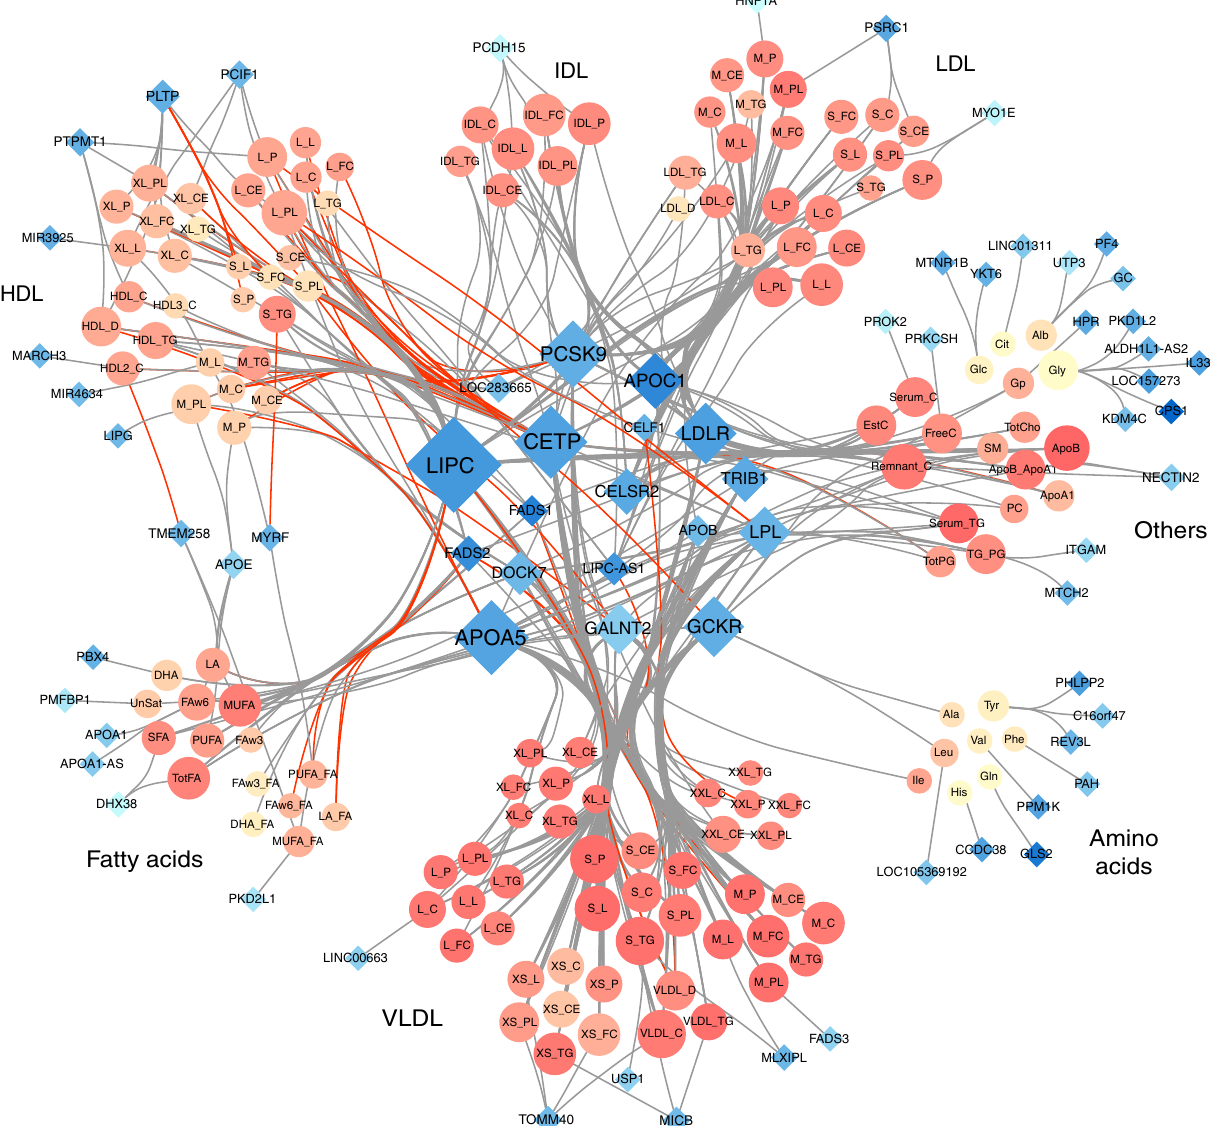
Fig. 3 Network representation of the 588 region-metabolite associations identi fi ed in the 158 metabolites GWAS in METSIM. For each region we used the nearest gene of the most associated variant. Each node represents either a gene (blue diamonds, N = 70) or a metabolite (orange circles, N = 147). Each edge is an association between one gene and one metabolite. Node size is directly proportional to the number of other nodes associated with it. Red edges correspond to opposite effect of a gene on a metabolite, compared with the other metabolites associated with the same gene. Metabolites colors (orange shades) represents correlation strength between a given metabolite and all other metabolites. Genes colors (blue shades) represent strength of correlation between a given gene and associated metabolites, quanti fi ed as the average of r 2 across all corresponding metabolites NATURE COMMUNICATIONS| (2019) 10:4788